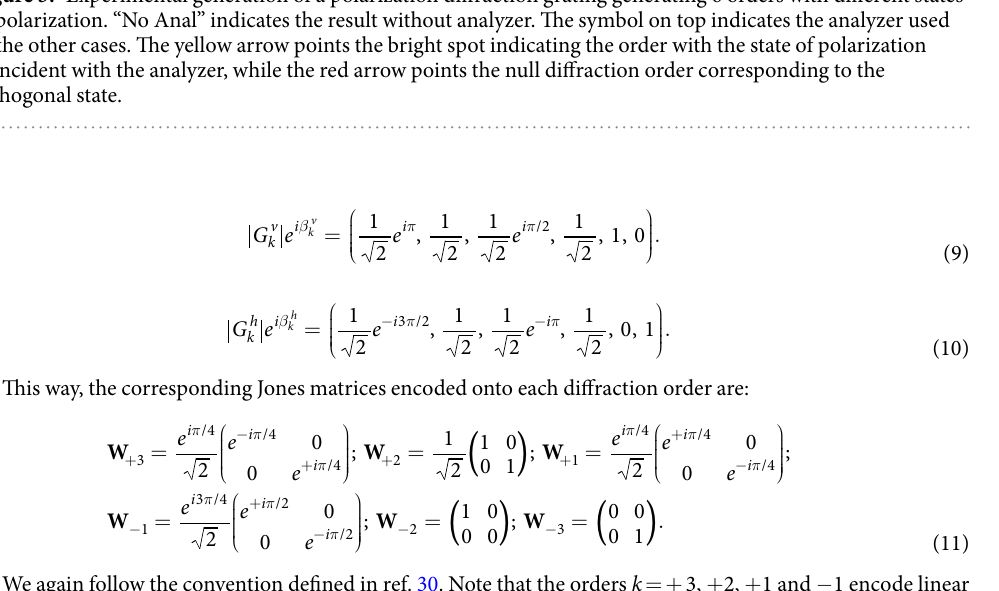
Fig. 1. The polarization diffraction grating is selected to diffract in the vertical direction. Here the input polariza- tion is selected to be linearly polarized oriented at 45°. Six diffraction orders with equal intensity are generated, but the states of polarization change in each order, according to the definition in the left column of Fig. 3. In the diffraction order k = + 3, the polarization will be rotated by − 45°, to become vertically polarized. In order k = + 2 the polarization will remain unchanged. In orders k = + 1 and k = − 1, the polarizations will be rotated by + 45° and + 90° respectively. Finally, in orders k = − 2 and k = − 3, the polarizations will be converted into LCP and RCP. The experimental results in Fig. 3 confirm this design. The column named “No Anal” refers to the case when no analyzer is placed before the detector, and shows the effective generation of the six target diffraction orders k = ± 1, ± 2, ± 3. Although the total diffraction efficiencies of the phase gratings reach about 90%, some other diffraction orders are visible because we captured saturated images. The images are saturated in order to show that, when a polarization analyzer is included in the system before the CCD detector, the diffraction order with the orthogonal state of polarization vanishes, as shown in Fig. 3 marked with a red arrow. On the other hand, the